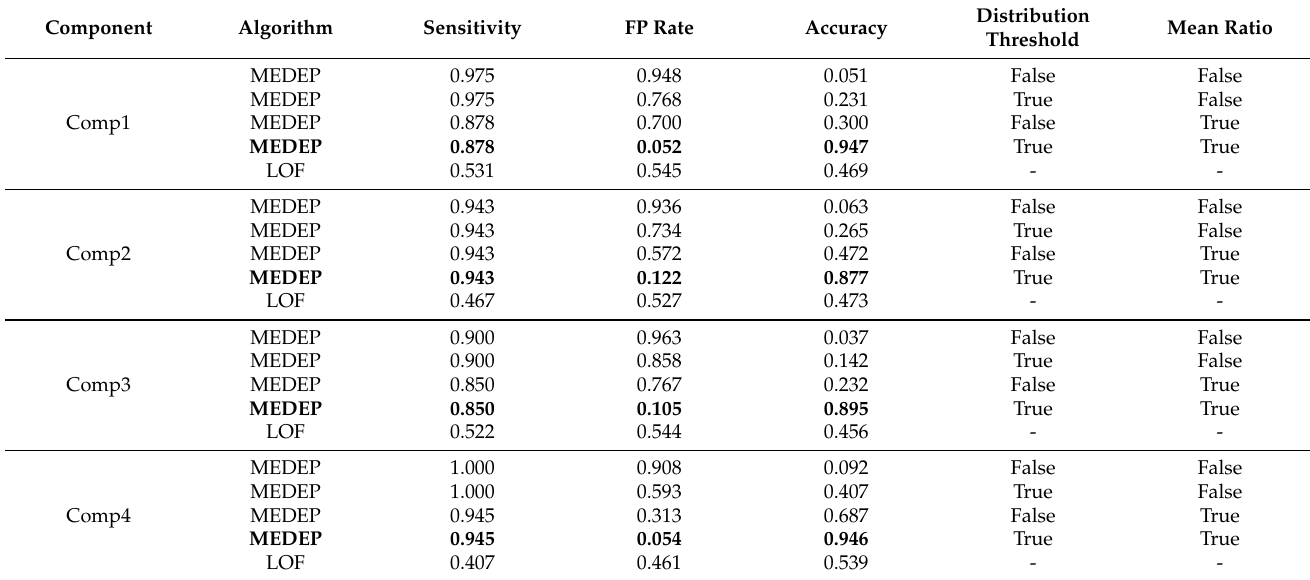
Table 4. Maintenance event detection results in Use Case 1. The best results for each metric are highlighted in bold.